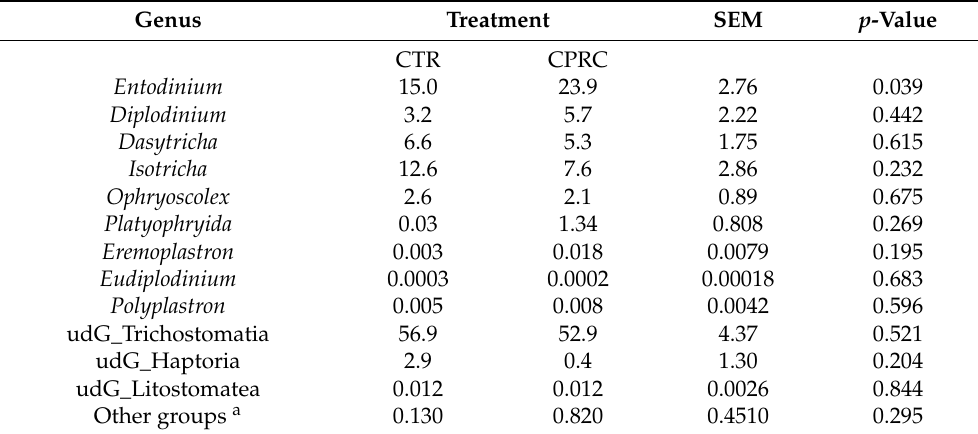
Table 6. Relative abundances (% of total ciliphora sequences) of Protozoal genera in the rumen digesta samples of cows fed a concentrate with cold-pressed rapeseed cake or a control concentrate.